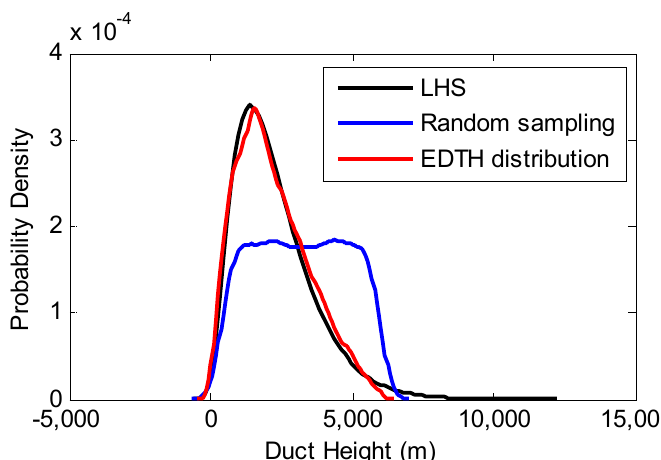
Figure 9. Comparison of LHS and random sampling.